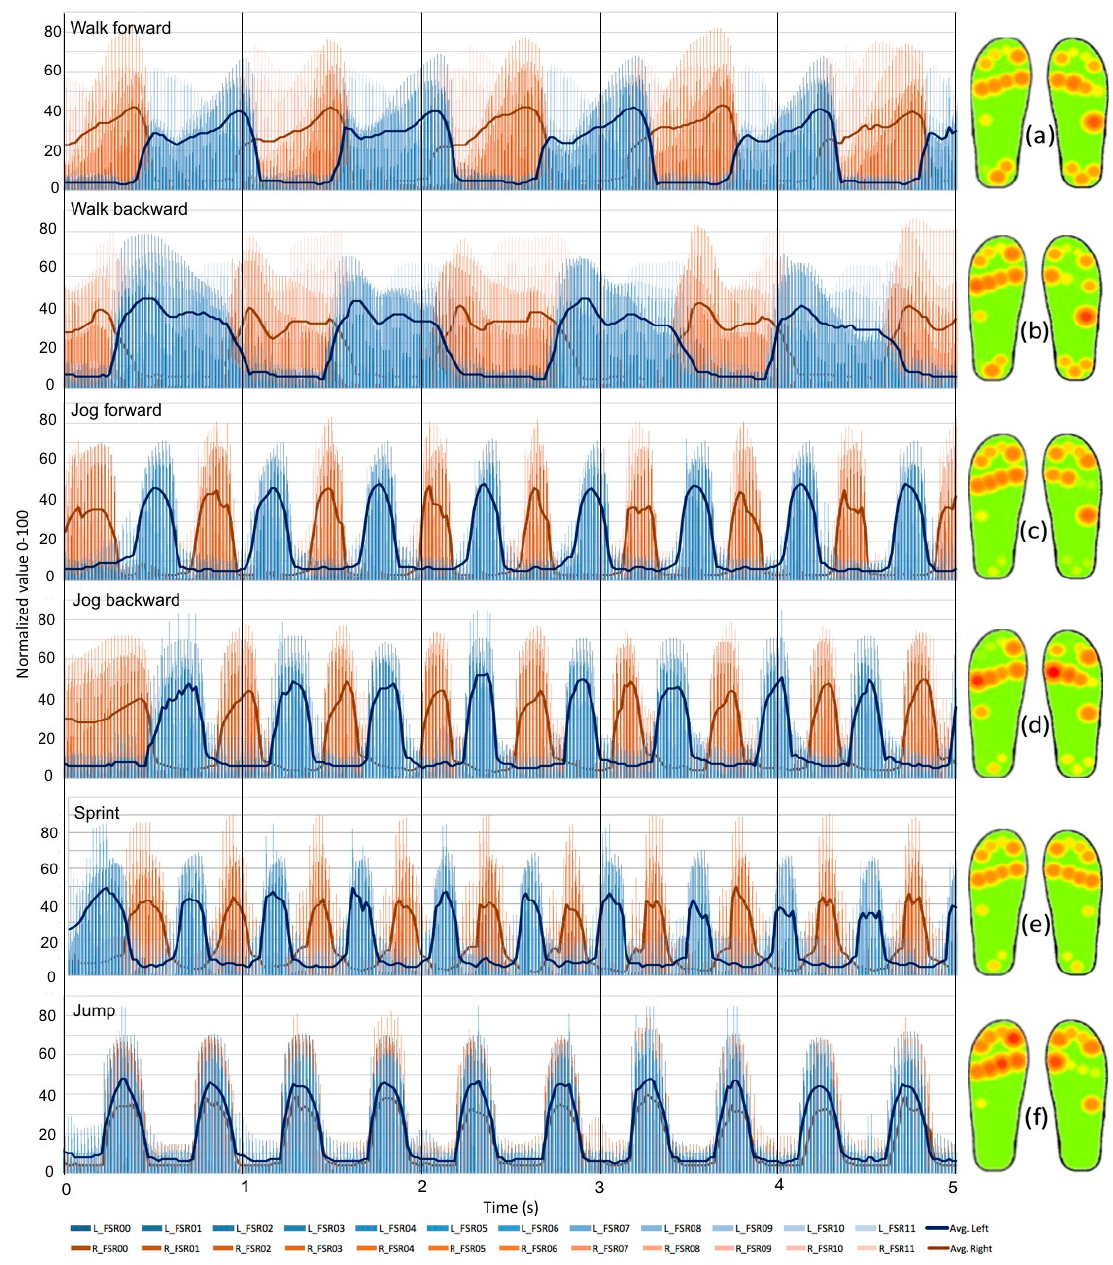
Figure 6. ( left ) A 5-second sample of FSR (Force-Sensitive Resistor) pressure values and the average pressure from all sensors in the left and right feet. Detectable patterns amongst different gait phases are shown. ( right ) Visualization of the average foot pressure data collected during the same performed activities: ( a ) Walk forward; ( b ) Walk backward; ( c ) Jog forward; ( d ) Jog backward; ( e ) Sprint; ( f ) Jump